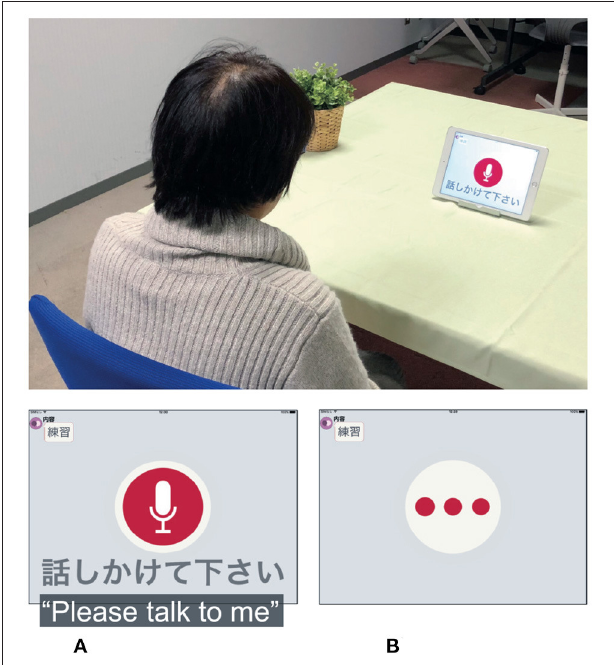
FIGURE 1 | Overview of experimental setup for collecting speech data. (A) Participant’s turn and (B) tablet’s